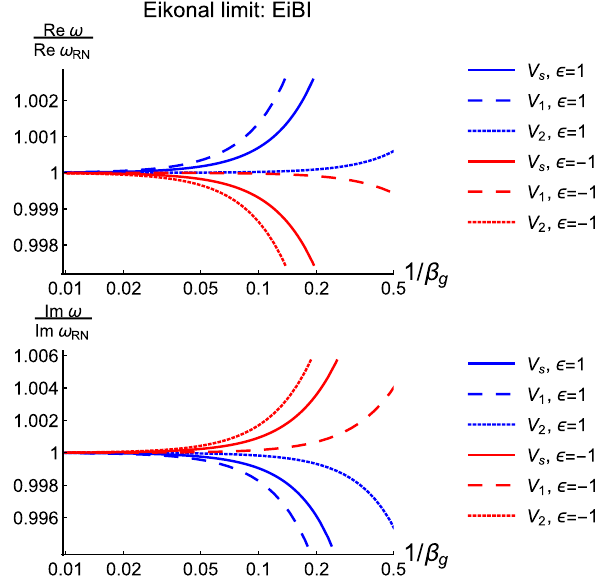
to α and the results are based on the potential V 1 (left) and V 2 (right). The multipole number and the charge are fixed to l = 2 and Q ∗ = 0 . 2, respectively